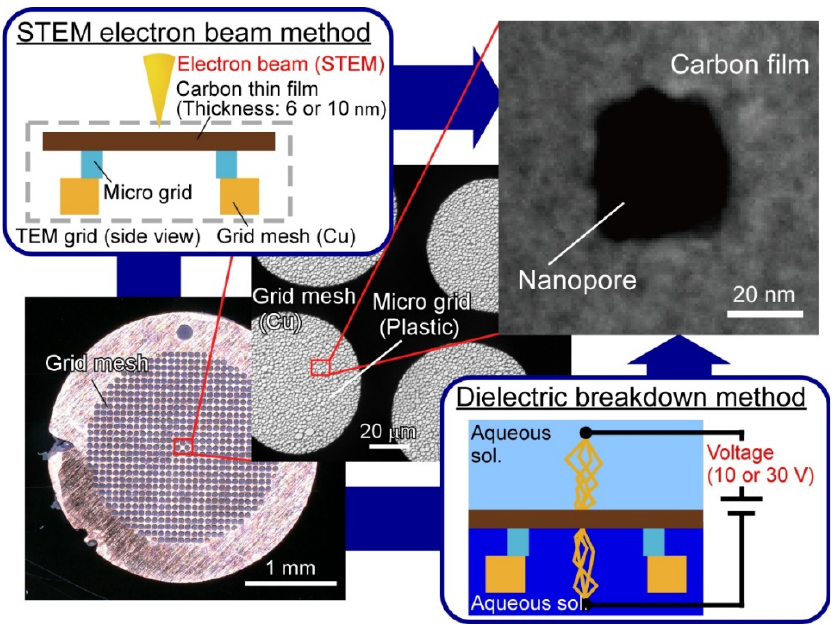
Figure 1. Schematic illustrations of strategies to fabricate solid-state nanopores in a carbon film on a micro-grid. The nanopores were fabricated by two different methods. One is the “STEM electron beam method”. In this method, the nanopores were fabricated using a STEM, by irradiating a focused electron beam on the carbon thin film. The other is the “dielectric breakdown method”. In this method, nanopores were formed by applying a trans-membrane voltage through the carbon thin film immersed in an electrolyte solution.